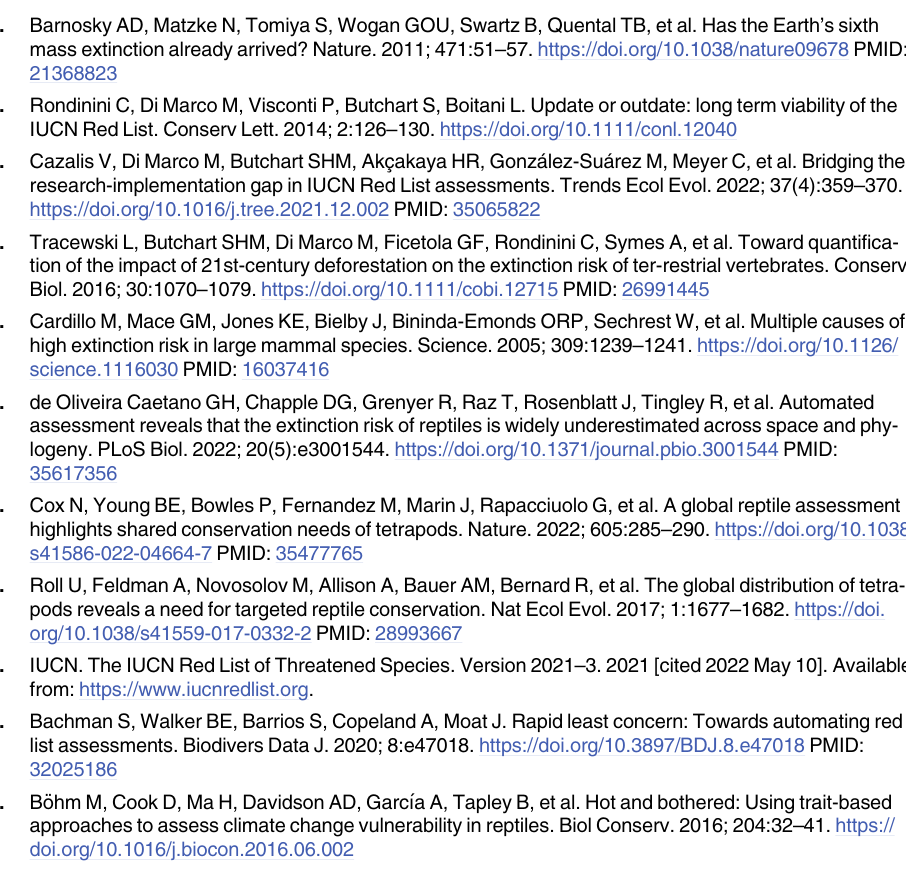
S1 Table. List of reptile species considered unassessed (and not used for model training) in the work of de Caetano Oliveira and colleagues and subsequently assigned a Red List cate- gory in 2021. The list only includes species having precise taxonomic correspondence with the latest release of the IUCN Red List database and being assigned a category of